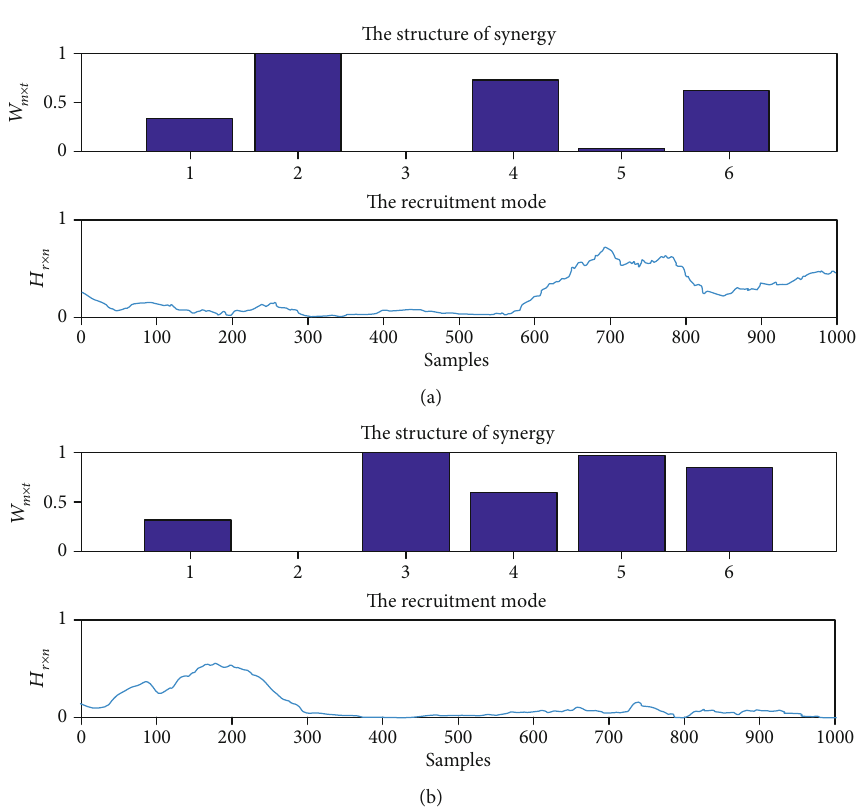
Figure 8: The typical results of muscle synergies of upper limbs for stroke patients during the HRI with clockwise circle-drawing movements. (a) The synergy pattern and activation coe ffi cients for the fi rst synergy; (b) the synergy pattern and activation coe ffi cients for the second synergy. The structure of synergy represents the synergy pattern of muscle synergies, and the recruitment mode represents the activation coe ffi cients of muscle